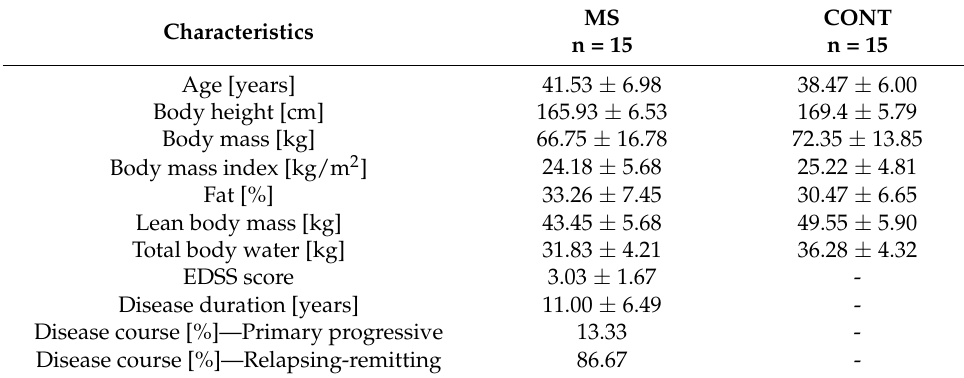
Table 1. General characteristics of the